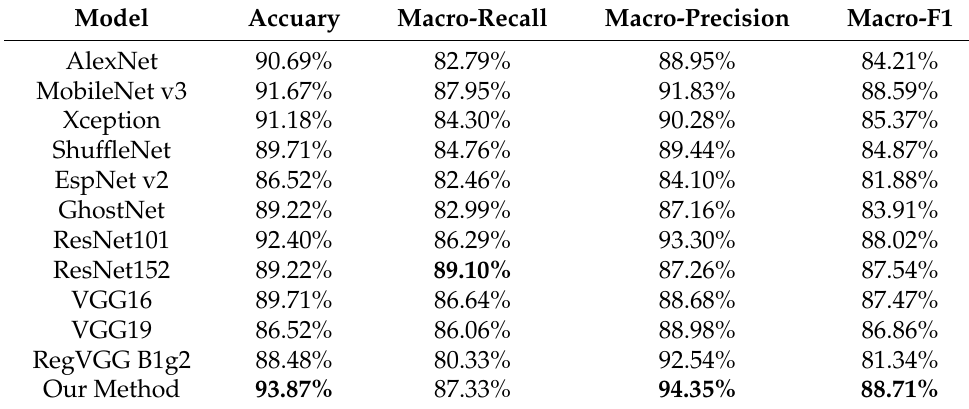
Table 1. The experimental results.